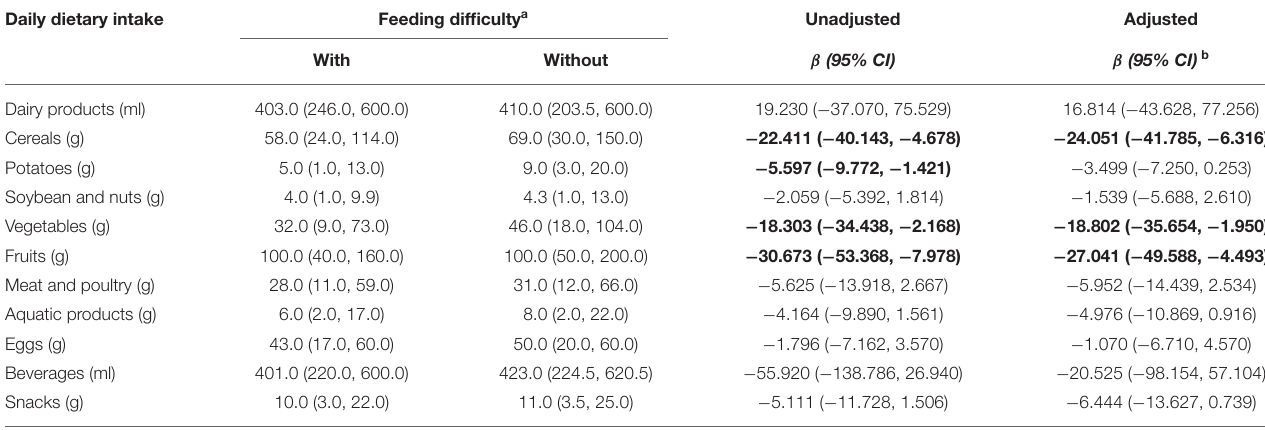
TABLE 3 | Difference of dietary intakes of children with or without feeding difficulty. Daily dietary intake Feeding difficulty a Unadjusted Adjusted With Without β (95% CI) β (95% CI) b